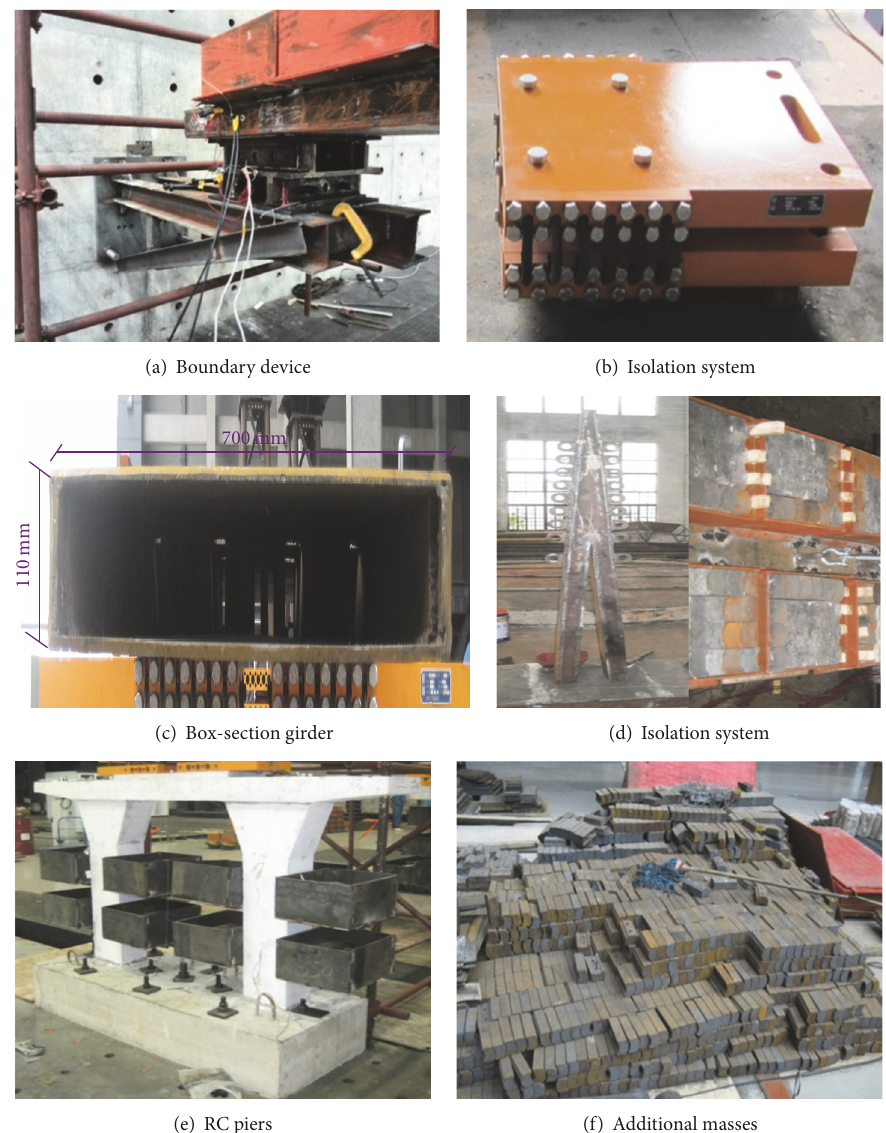
Figure 3: Detailed information of bridge